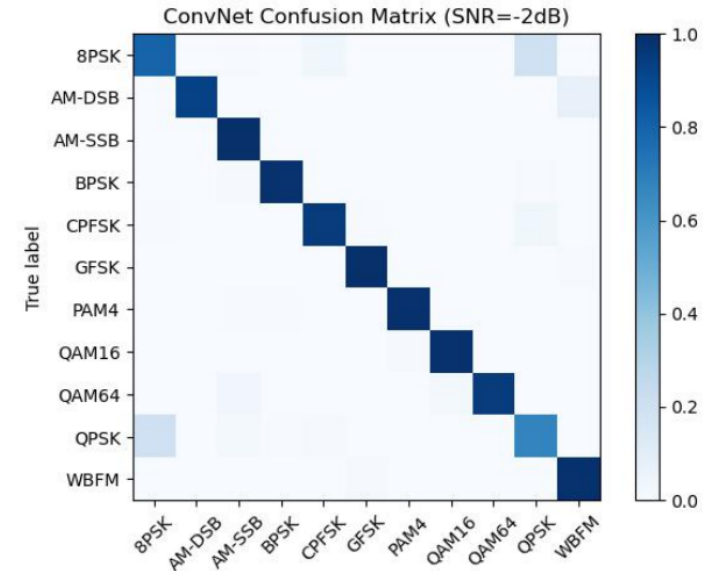
Figure 11. Confusion matrix on SNR = − 2 dB